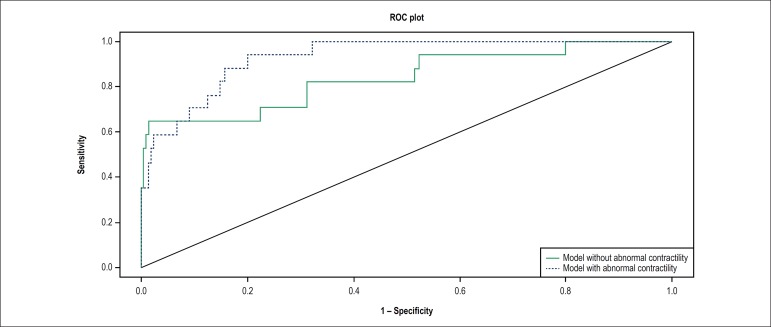
Roc curve of the multivariate model with and without evaluation of
segmental abnormal contractility.